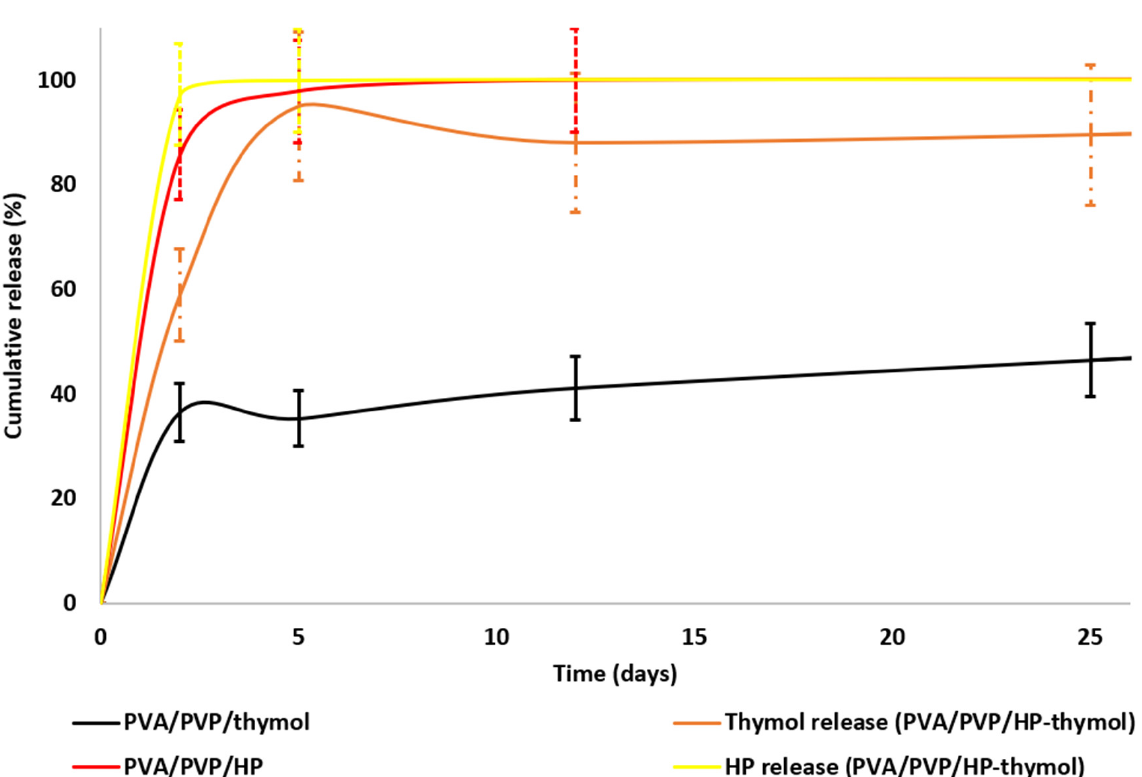
Figure 4. Cumulative release of HP from PVA/PVP/HP (red), thymol from PVA/PVP/thymol (black) and HP (yellow) and thymol (orange) from PVA/PVP/HP-thymol hydrogel coatings to the hay environment. Release rates were measured in triplicate.